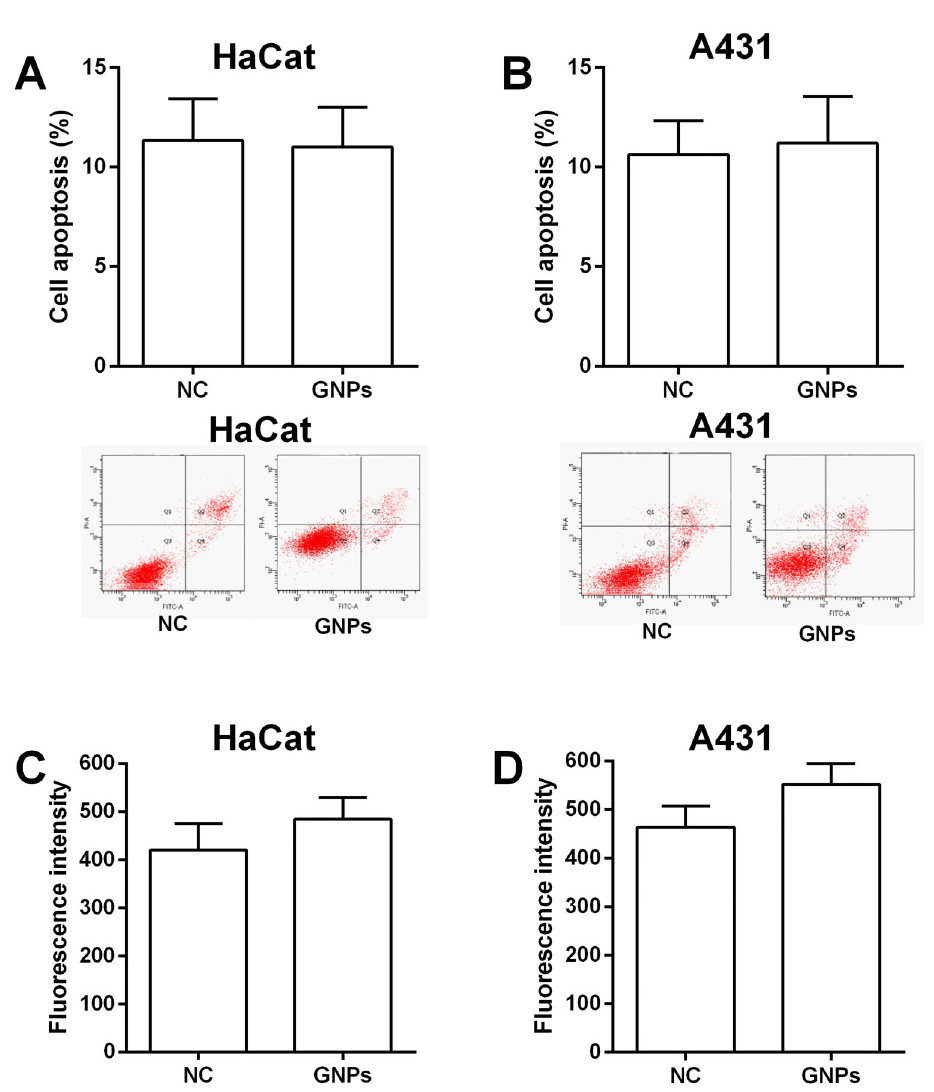
Figure 3. Effects of gold nanoparticles (GNPs) on cell apoptosis and singlet oxygen generation. Cell apoptosis of ( A ) HaCat and ( B ) A431 cells after being treated with phosphate-buffered saline (PBS (NC)) or GNPs was determined by fl ow cytometry (unpaired t -test). Singlet oxygen generation of ( C ) HaCat and ( D ) A431 cells after being treated with PBS (NC) or GNPs was determined by SOSGR assay (unpaired t -test). Data are reported as means ± SD